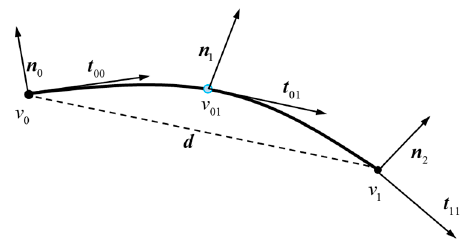
Figure 2. Hermite curve.